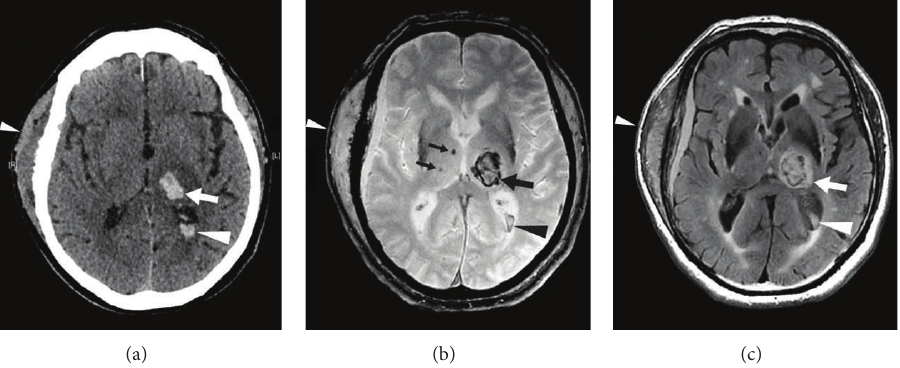
Figure6:CTscan(a)andgradient-echo-weighted(b)andFLAIR(c)imagingshowingahypertension-relatedleft-sidedthalamichemorrhage (large arrows on a, b, and c) and surrounding edema, complicated with a intraventricular hemorrhage (large arrowheads on a, b, and c) and associated with chronic hypertension-related microbleeds in the right thalamus (small arrows on b) and a subcutaneous and subdural hemorrhage (small arrowheads on a, b, and c) related to trauma (caused by acute right hemiplegie due to the thalamic hemorrhage).